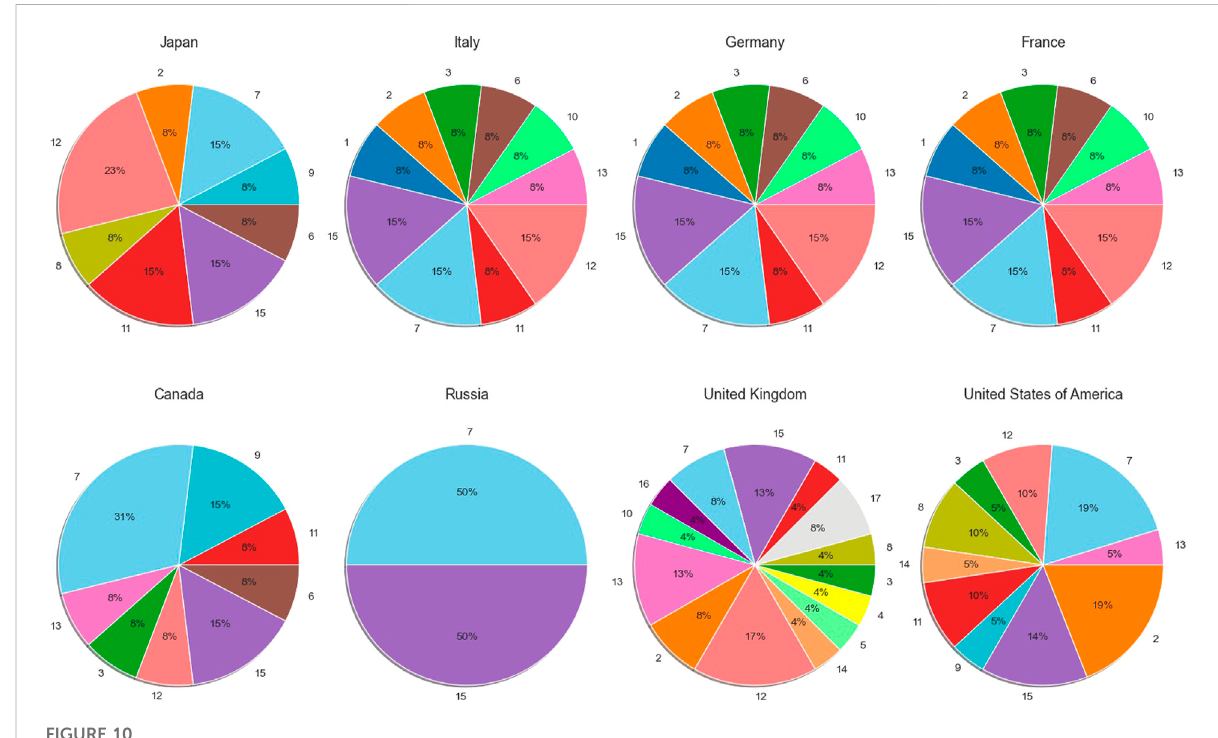
FIGURE 10 Association between the NDCs and the SDGs for the G8 countries.